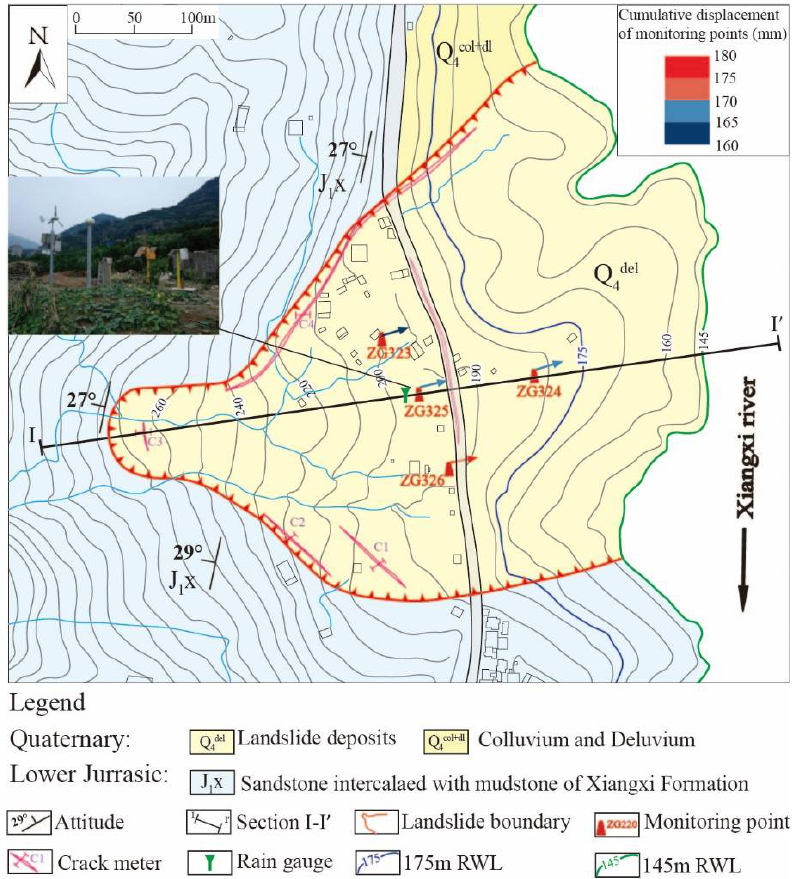
Figure 3. The monitoring system and geological map of the Baijiabao landslide (colored arrows demonstrate the direction and magnitude of the monitoring points).